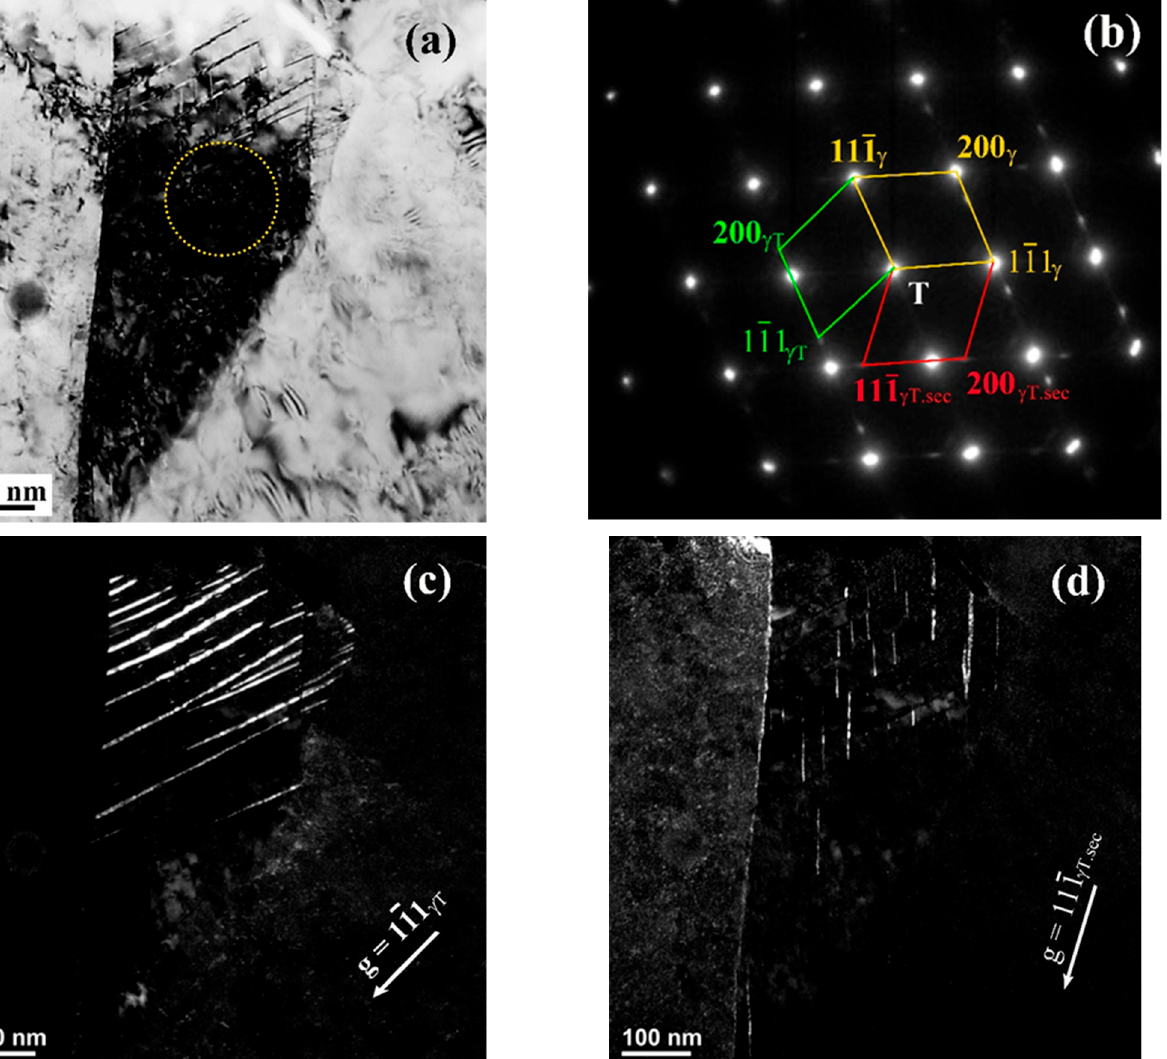
Figure 12. ( a ) TEM bright field image showing the formation of high density of deformation twins and dislocation tangles in an austenite grain in a specimen tested at 225 °C to fracture. ( b ) SADP from the area marked by the yellow circle in ( a ). The beam direction is [ 011 ] austenite phase, γ T : primary deformation twins, γ T.sec : secondary deformation twins. ( c ) TEM dark field image showing primary deformation twins. ( d ) TEM dark field image showing secondary deformation twins.